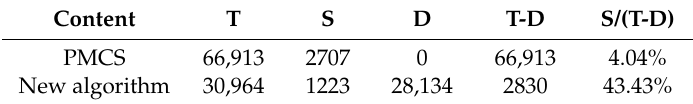
Table 3. Comparison of sampling amounts with traditional PMCS and the ISSR-based